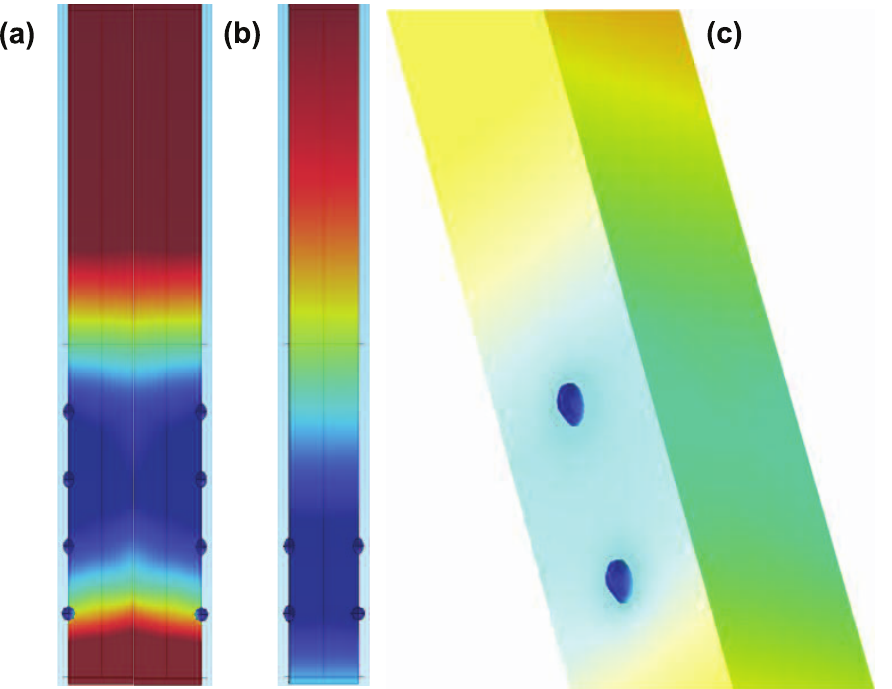
Figure 5. Three-dimensional numerical models of oxygen diffusion microscope slide chamber where oxygen diffuses from the top and the bottom. Blue dots represent bacteria that absorb oxygen as it diffuses past. The columns are 100 m m high (a and b). The relative concentration difference between blue and red is 30 mM. Orthogonalized spacings represent average cell distributions seen in the experiments with (a) for low cell density regions and (b) for cell cluster regions. Real distributions will be heterogenously rather than uniformly distributed. The diagonal in (c) is the rotated volume showing the z axis and the position of the bacteria in that direction. specific search pattern trajectories used have been overlaid. The Table S2 Experimental number of recordings (n) for V. red and yellow lines are flicks, the orange and white lines are coralliilyticus search pattern changes over time in Figure 4. straight swimming, and the blue line is a run and reverse. Examples of the 90 u flicking events are marked by an X. Table S1 Experimental number of recordings (n) for V. coralliilyticus search pattern preference from oxic to anoxic conditions in Figure 3.